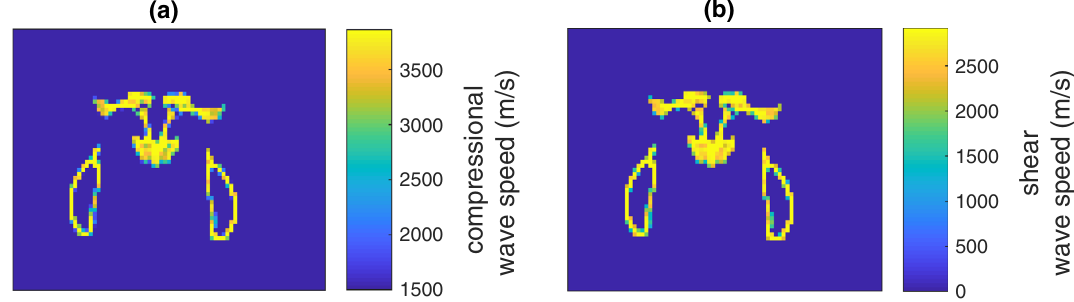
Figure 3. (a) Compressional and (b) shear wave speed values for a slice of the computed tomography scan in a water